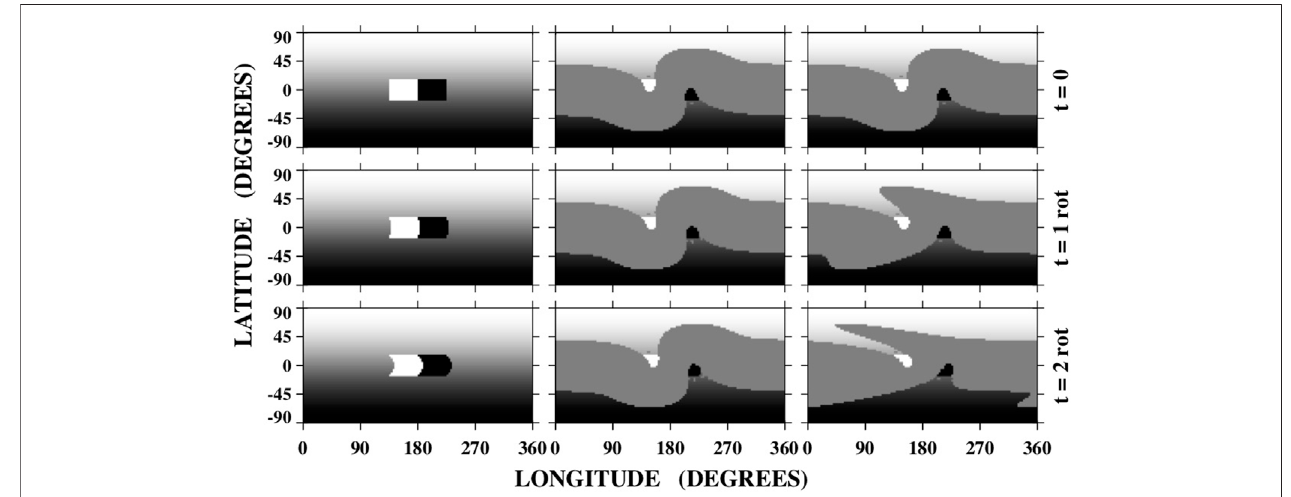
FIGURE 1 | The quasi-rigid rotation of a coronal hole, as illustrated by a con fi guration consisting of a bipole at the equator and an axisymmetric dipole fi eld. The underlying photosphere rotates attheSnodgrassrate ω ( L )=13.38 − 2.30sin 2 L − 1.62sin 4 L degday − 1 ,where L islatitude. Leftcolumn: Photospheric fl uxdistributionafter the lapse of 0, 1, and 2 rotations. Middle column: Corresponding open fi eld regions, determined by applying a PFSS extrapolation to the photospheric fi eld. Right column: Open fi eld regions as they would appear if they rotated at the photospheric plasma rate. In a frame corotating with the equatorial bipole, the photospheric fl ux distribution and thus the distribution of open fl ux remain practically unchanged with